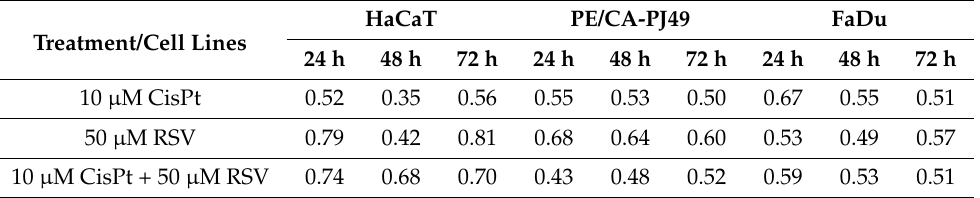
Table 2. The index of proliferation (IP) for tumor cell line PE/CA-PJ49, FaDu, and normal cell line HaCaT treated with RSV and/or CisPt for 24, 48, and 72 h. IP is equal to absorbance of treated cells/absorbance of untreated cells. Results are expressed as mean values of three determinations ± standard deviation (SD). Untreated cells serve as control and are considered to have the index of proliferation (IP) equal to